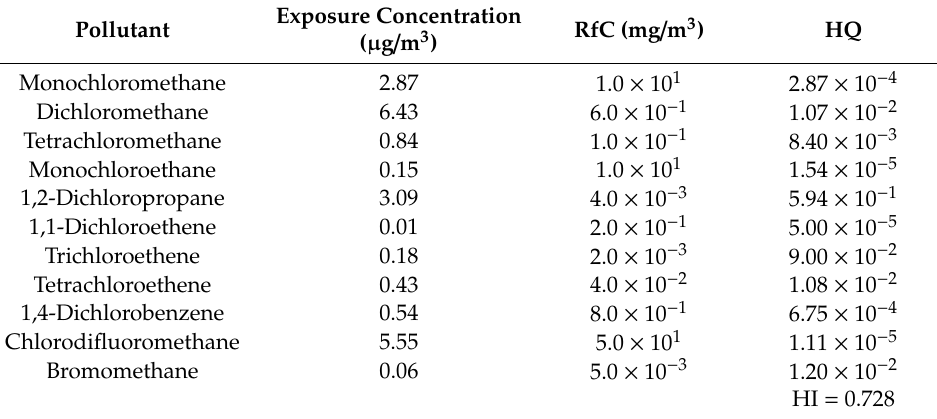
Table 4. Non-carcinogenic risk assessment for 11 volatile halogenated